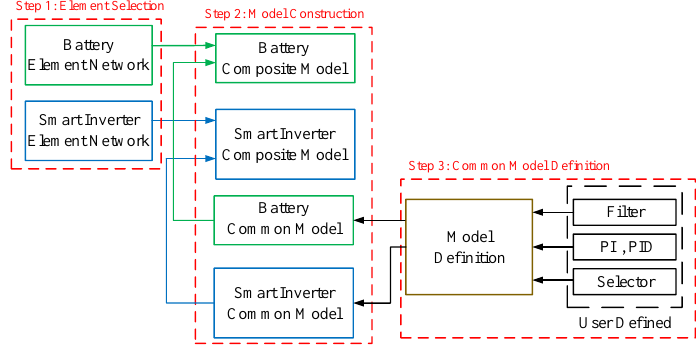
Figure 2. Schematic diagram of DSL model